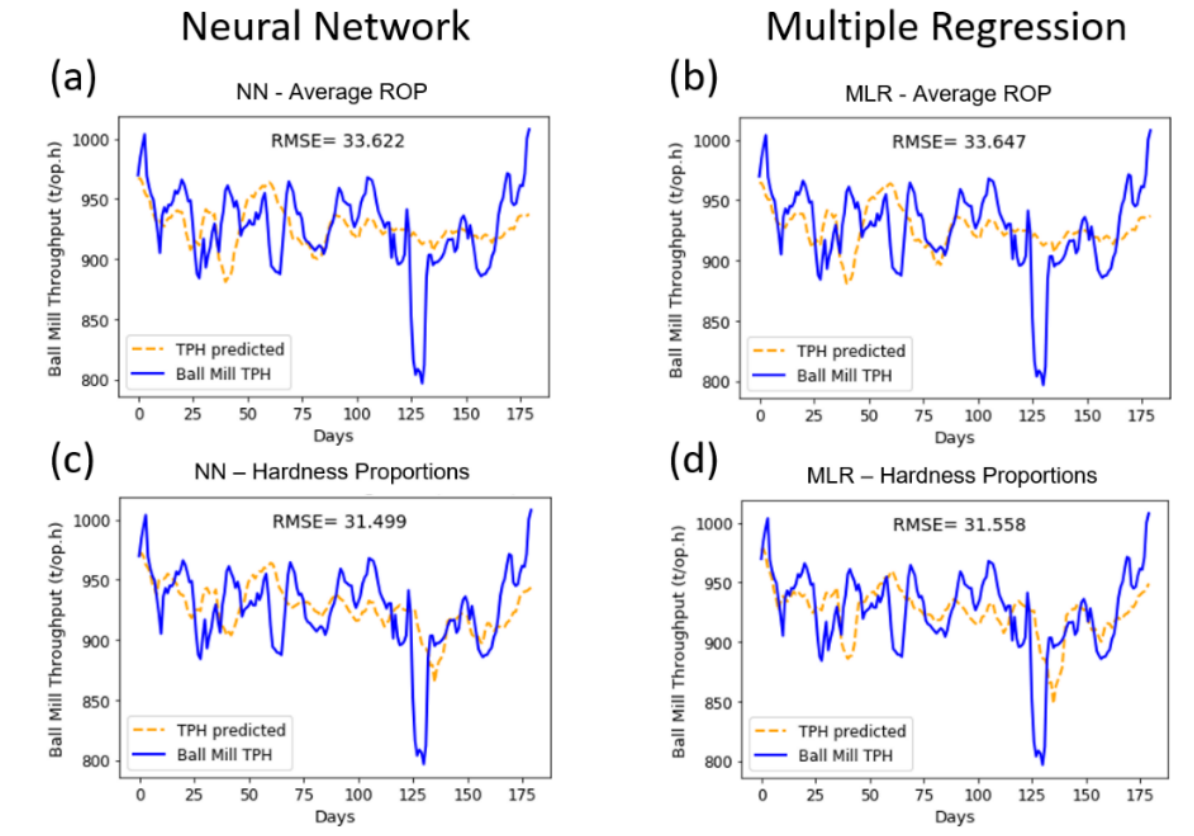
Figure 6. Ball mill throughput prediction (20-fold cross-validation) using ( a ) average ROP (NN), ( b ) average ROP (MLR), ( c ) hardness proportions (NN), and ( d ) penetration rate categories (MLR).